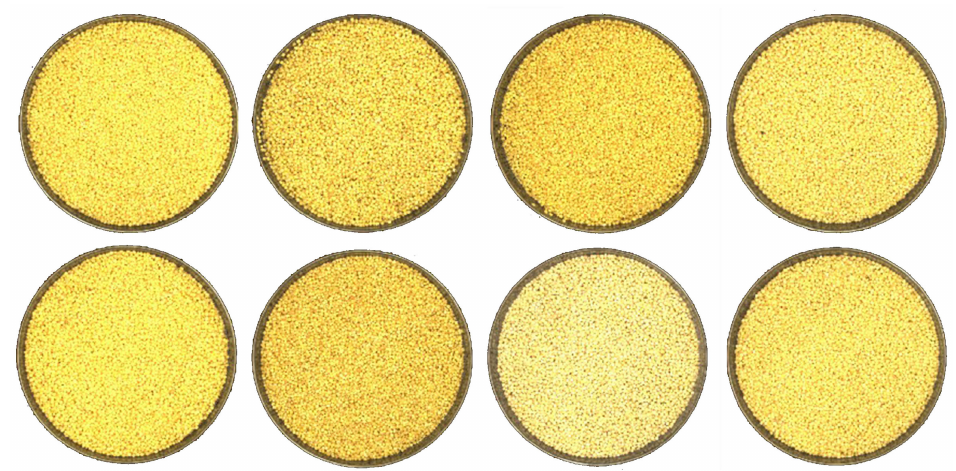
Figure 1. Representative millet samples used in the